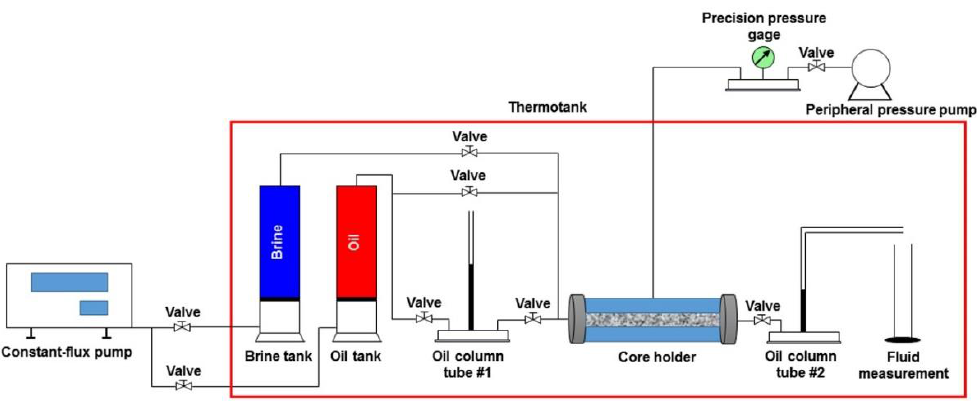
Figure 2. The schematic of a TPG measurement.